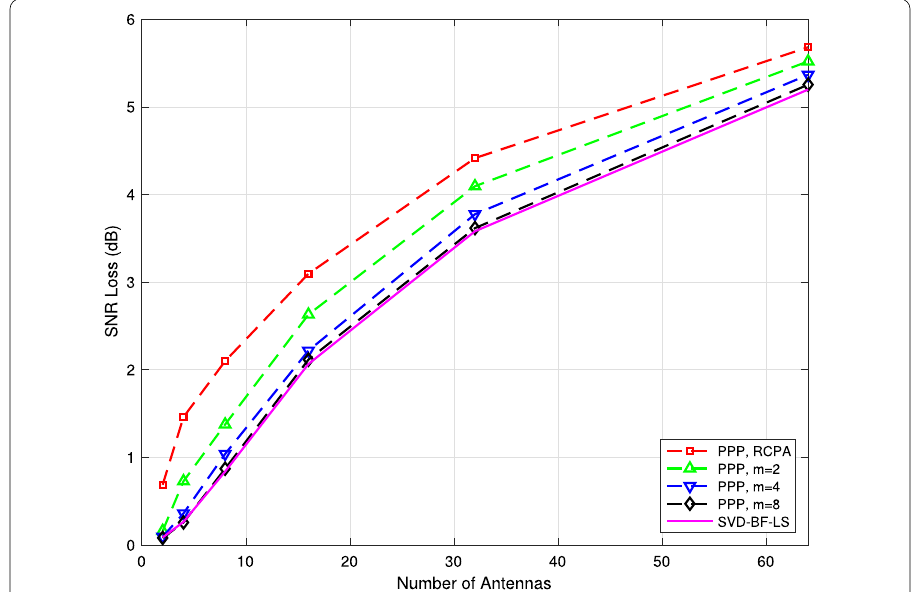
8 iterations) 1 , PIA with m 2 , m 4 and m = = = =